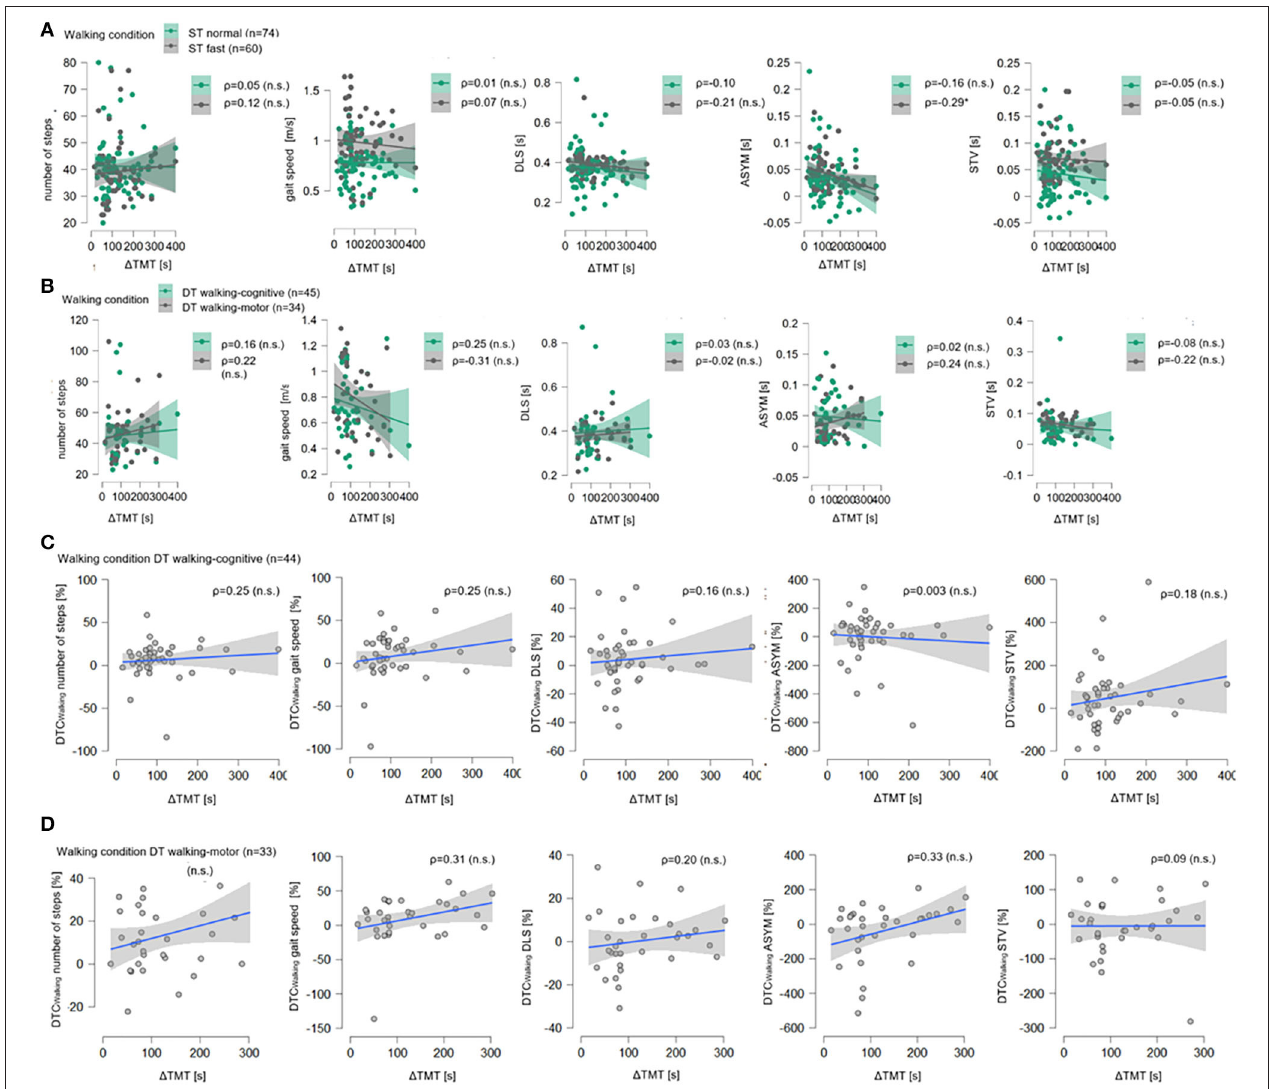
FIGURE 2 | Correlation plots for 1 TMT with all walking parameters. In (A) , for the single-task normal pace walking condition (ST Normal, green) and the single-task fast pace condition (ST Fast, gray), all five walking parameters, i.e., number of steps, gait speed (in meter per seconds, m/s), double limb support (DLS), asymmetry (ASYM), and step time variability in seconds (STV, s) are shown on the ordinates, the delta of Trail Making Test (part B minus part A, 1 TMT) is on the abscissas. Sample size N is given as well as Spearman’s rank correlation ( ρ ) between 1 TMT and each walking parameter, significant correlation coefficients are marked with * (level of significance p ≤ 0.05), non-significant ones are marked with (n.s). For each condition, data points (dots) and regression lines with confidence intervals (lines with surrounding boxes) are shown. In (B) the same is shown for the dual-task motor-cognitive walking condition (DT motor-cognitive, green) and the dual-task motor-motor condition (DT motor-motor, gray). In (C) , for DT motor-cognitive walking condition the dual-task costs while walking in percentage (DTC Walking , %) for all five walking parameters are shown on the ordinates, the delta of Trail Making Test (part B minus part A, 1 TMT) are on the abscissas as well as Spearman’s rank correlation ( ρ ) between 1 TMT and each DTC Walking . Data points (gray dots) and regression lines with confidence intervals (blue lines with surrounding gray boxes) are shown for each parameter. The same is shown in (D) for the DT motor-motor walking condition.